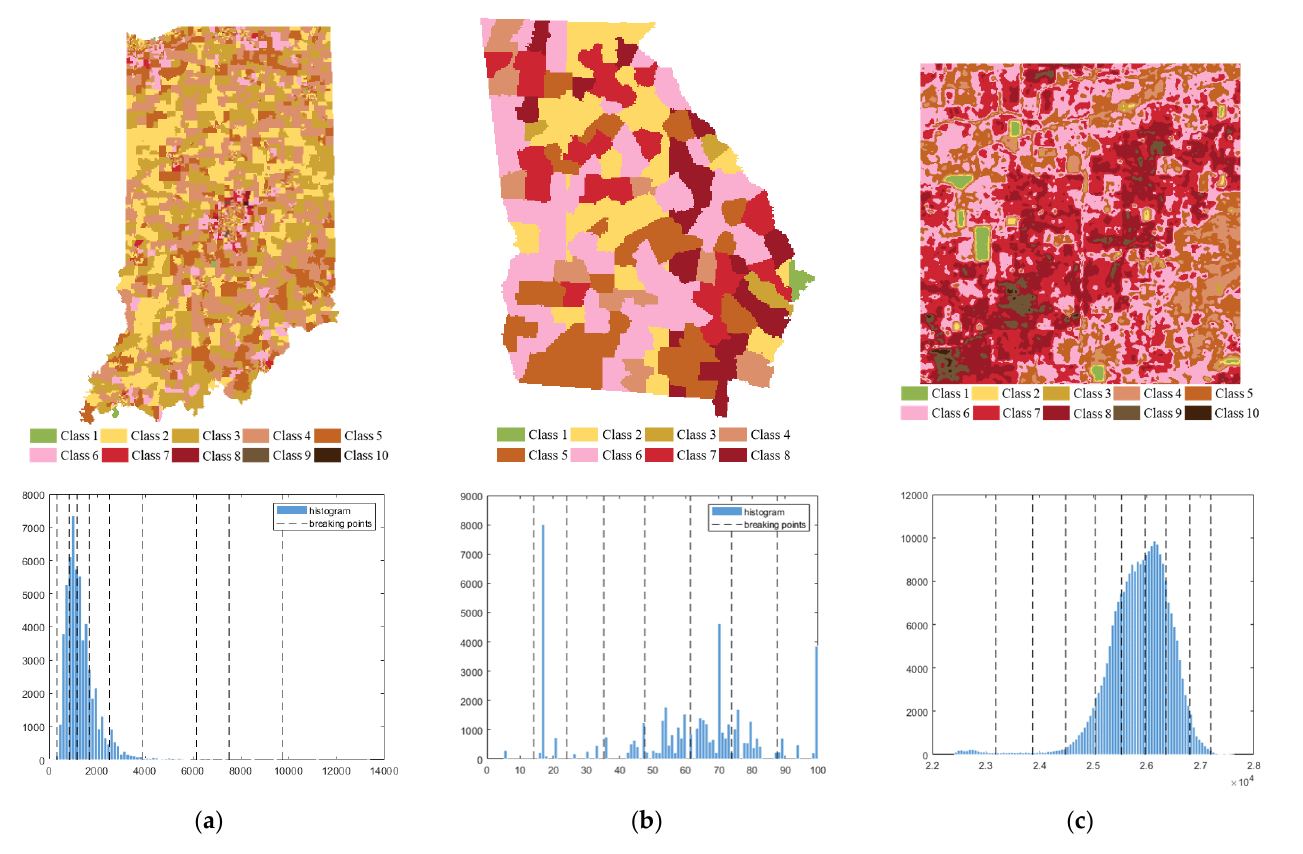
Figure 9. Classification results of the population of Indiana ( a ), the simulated population of Georgia ( b ), the thermal band ( c ), and the break points using adaptive GIC for multi-peak data.